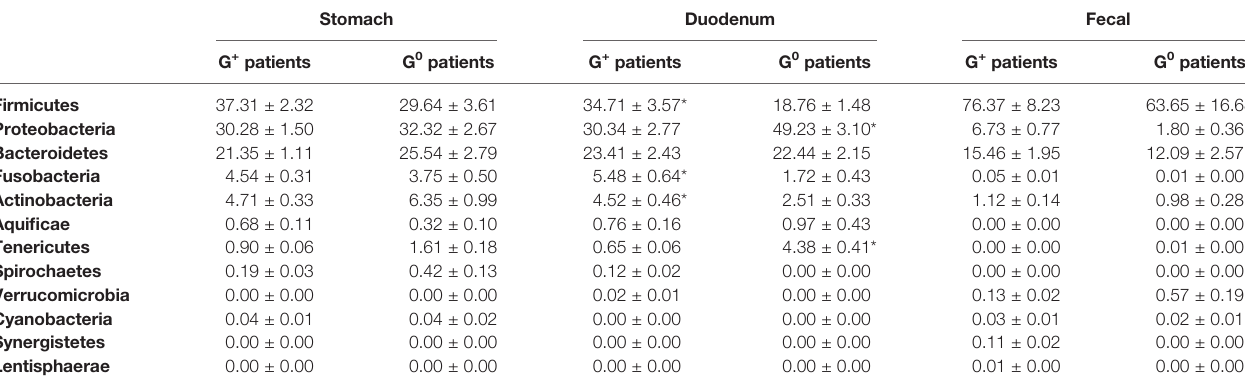
TABLE 3 | Relative abundances of stomach, duodenal and faecal microbiota composition in G 0 and G + patients. Stomach G + patients G 0 patients G + patients G 0